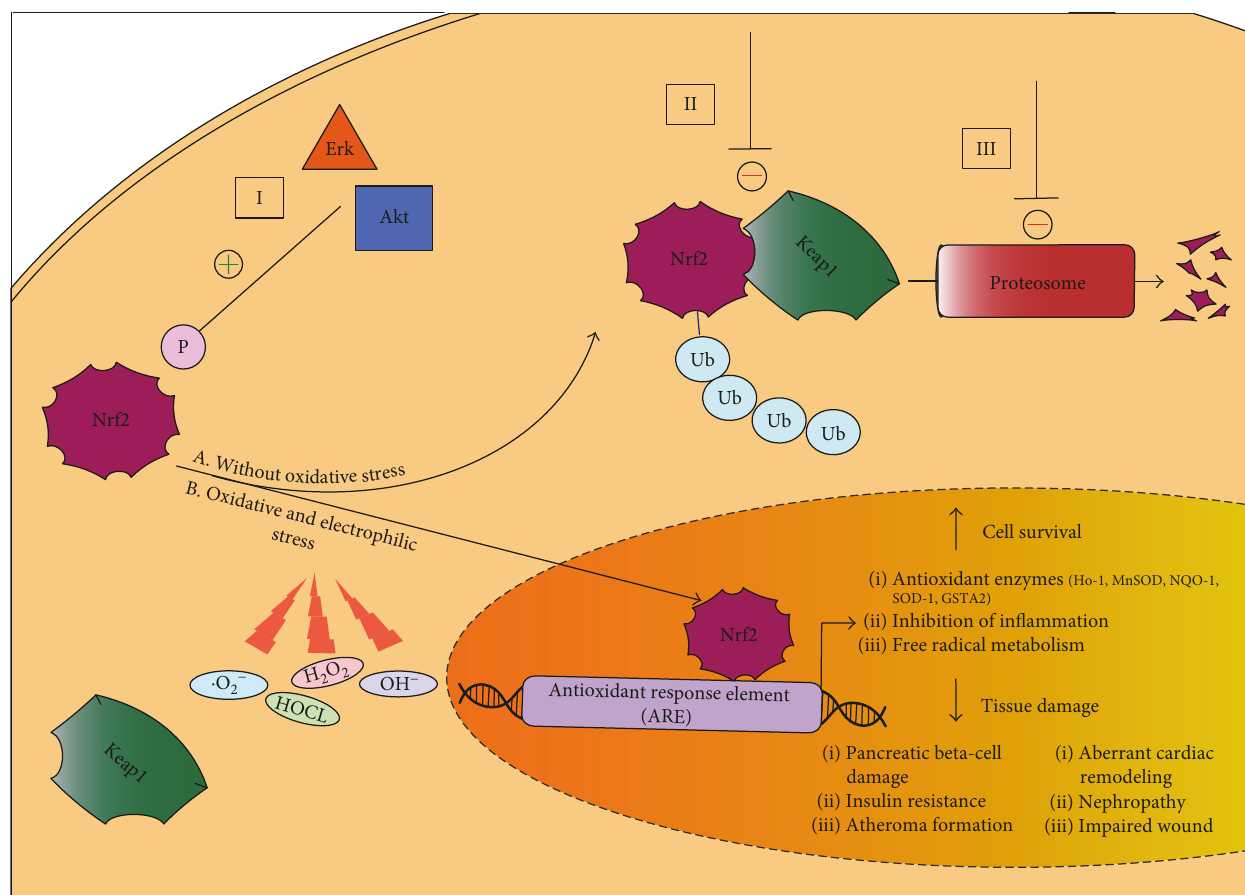
Figure 1: The Nrf2/Keap1/ARE pathway in type II diabetes mellitus. (A) Under nonstressed conditions, the Nrf2 transcription factor is covalently bound to cysteine residues on its native repressor Keap1 in the cytoplasm. This results in the constitutive ubiquitination and degradation of Nrf2 in the proteasome and inhibition of the anti-oxidant response. (B) Under conditions of electrophilic or oxidative stress, cysteine residues on Keap1 are modi fi ed, resulting in the stabilization and translocation of Nrf2 into the nucleus, where it can bind to the promoter region of the ARE and initiate the transcription of various cytoprotective enzymes which function to promote cellular survival through a variety of mechanisms, including the upregulation of antioxidant function, in fl ammatory inhibition, and the transport of toxic metabolites. These cellular adaptations have been shown to improve a wide array of tissue damage underlying the pathogenesis and progression of diabetes. (B) There are three major mechanisms of Nrf2 induction by small molecule activators. (I) Upstream kinases such as Akt and Erk phosphorylate Nrf2 at speci fi c sites, favoring its release by Keap1 and nuclear translocation. (II) Modi fi cation of Keap1 cysteine residues disrupts the Nrf2-Keap1 complex, favoring dissociation of Nrf2 and subsequent nuclear translocation. (III) Inhibition of Nrf2 ubiquitination by Keap1 and degradation by the proteasome augments Nrf2 availability, thus favoring nuclear translocation of Nrf2. Ub: ubiquitination; P: